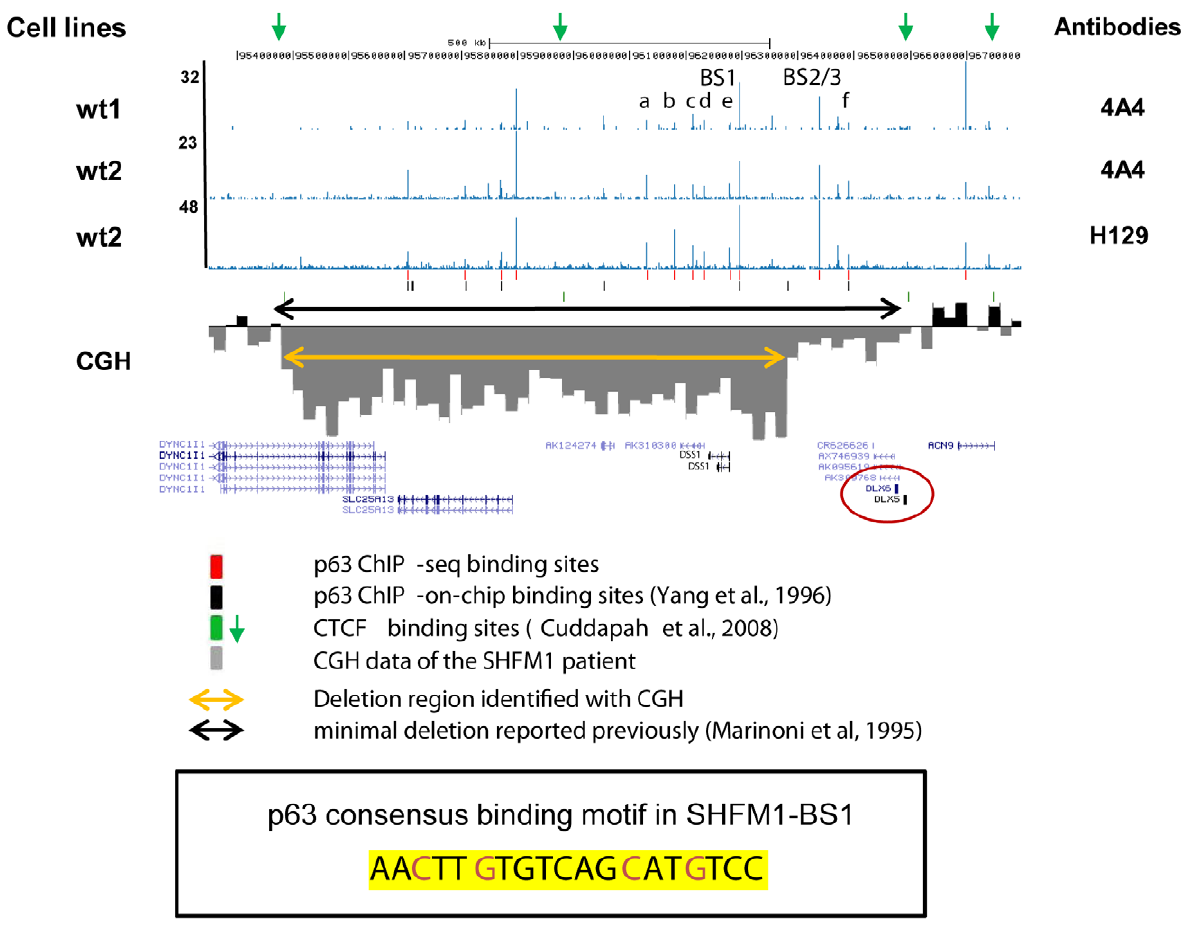
Figure 3. A microdeletion at SHFM1 locus on chromosome 7. A screenshot of UCSC genome browser shows the p63 binding profile from two HKC cell lines (wt1 and wt2) with two p63 antibodies (4A4 and H129) near DLX5 and DLX6 on chromosome 7. SHFM1-BS1, -BS2 and -BS3 are three high peaks and a–f are low ones. SHFM1-BS2 and -BS3 are in close proximity and therefore seen as a single peak in this large genomic view. Ultra-high Comparative Genomic Hybridization array analysis performed with DNA of a SHFM1 patient showed a chromosomal deletion of 880 kb on chromosome 7 (95,390,000–96,270,000, hg18, the orange arrow) which includes DSS1 , SLC25A13 and part of DYNC1I1 but not DLX5 and DLX6 . Breakpoints and 20kb averaged log2 ratios were visualized in the genome browser. A previously reported minimal deletion determined by markers D7S527 and D7S1796 [28] is marked with a black arrow. Binding sites identified in this ChIP-seq study and in previous ChIP-on-chip [17] are labeled in red and black, respectively. CTCF binding sites revealed by previous ChIP-seq analysis [46] are labeled in green and two binding sites